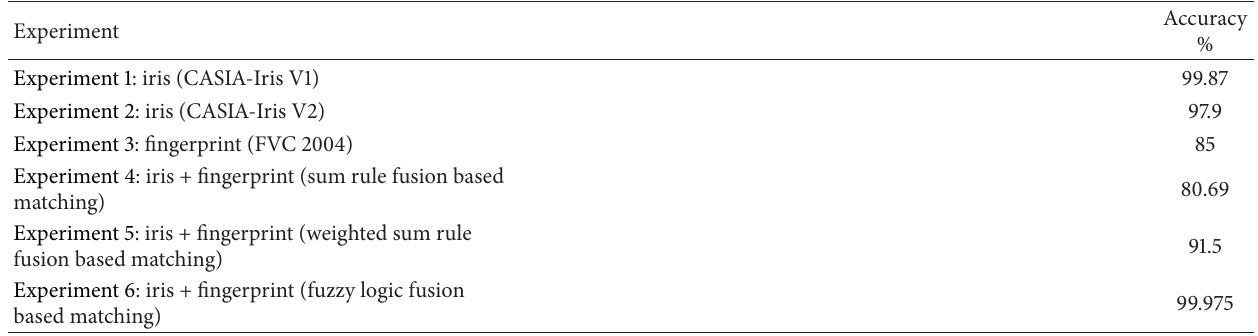
Table 9: Accuracy comparison of all the implemented systems.